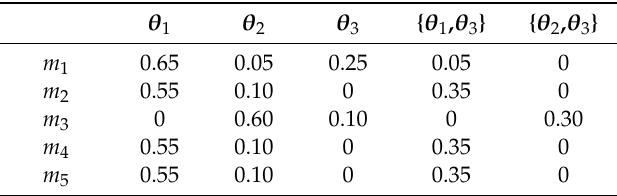
Table 5. Basic probability distribution of multi-sensor